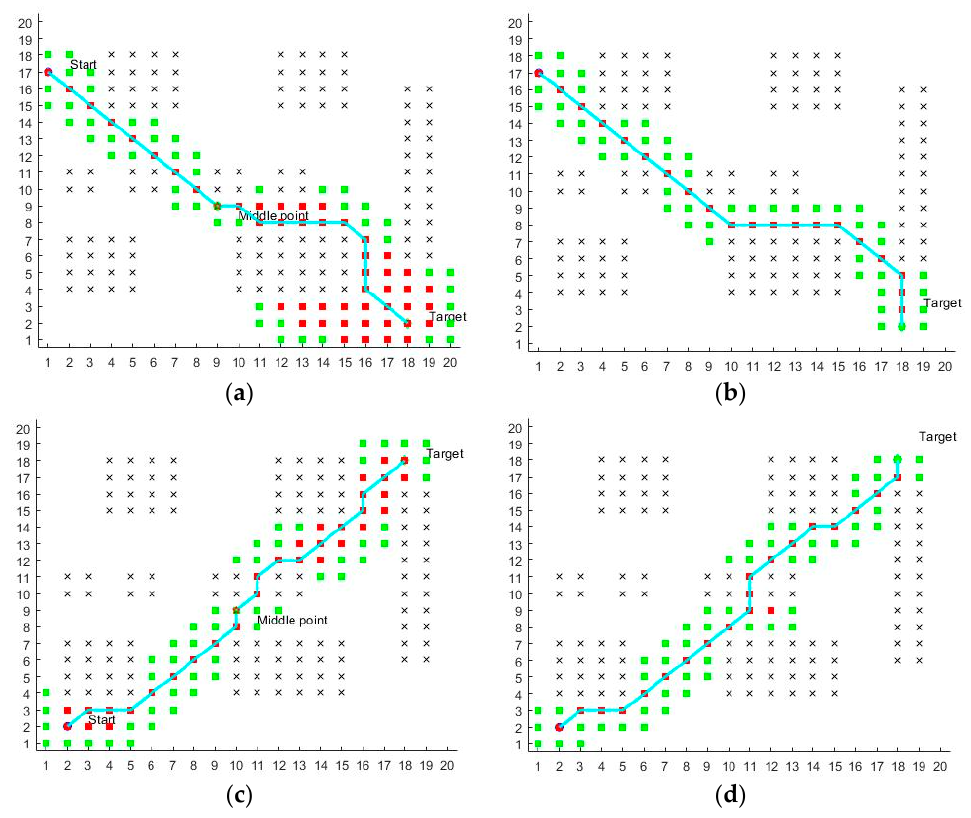
Table 4. Comparison of path-planning times based on Figure 14a,b (unit: s).